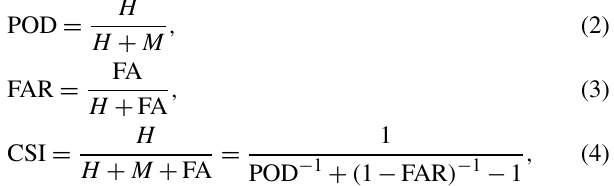
olds associated with different rainfall durations are directly extracted from Fig.